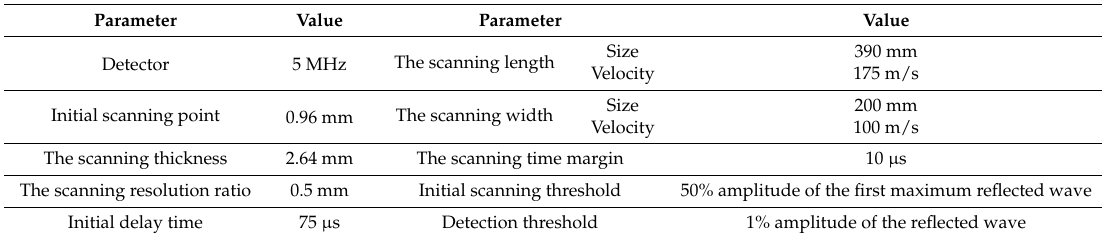
Table 3. Parameters of ultrasonic C-scanning.